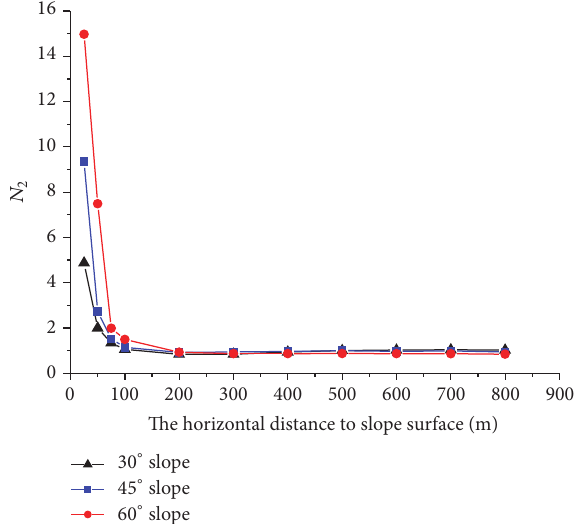
Figure 7: Variation curves of 𝑁 2 at the elevation of 0m in different slope angles when the lateral pressure coefficient is equal to